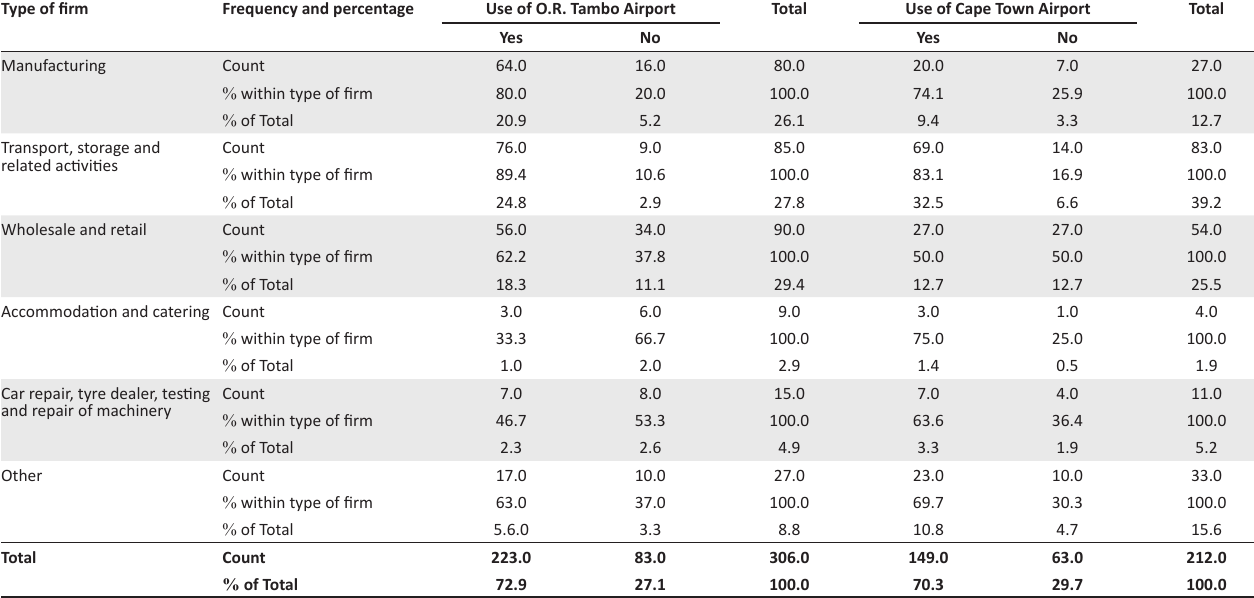
TABLE 4: O.R. Tambo and Cape Town airport-centric firms’ use of the airports. Type of firm Frequency and percentage